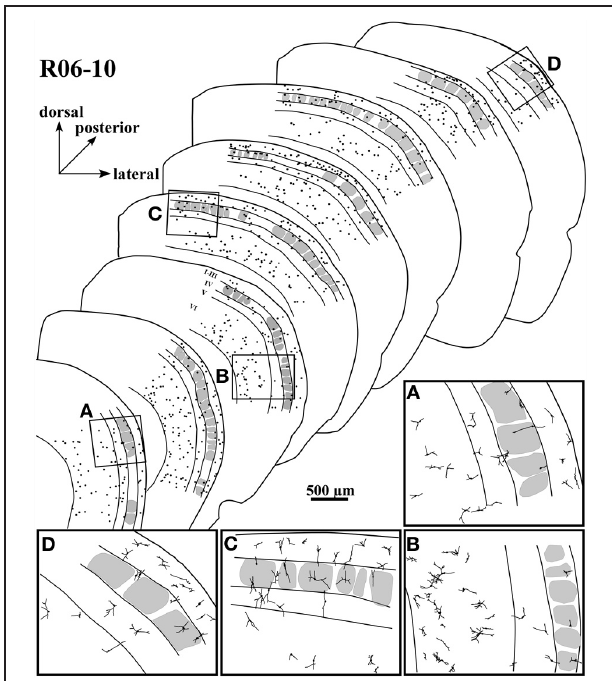
FIGURE 5 | Spatial distribution of nitrergic neuronal cell bodies in selected sections of hemisphere R06-10, disposed from anterior (lower left) to posterior (upper right). The four inserts below (from A to D ) correspond to drawings in higher magnification from the respective regions framed in four of the sections. Most of the cells seem to concentrate in supragranular layers and in layer